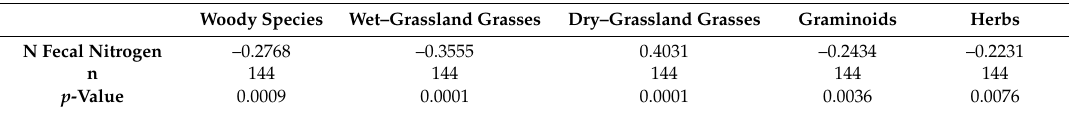
Table 4. Spearman’s correlation coe ffi cients between the functional groups of plants in the vicuña diet and the N content of their